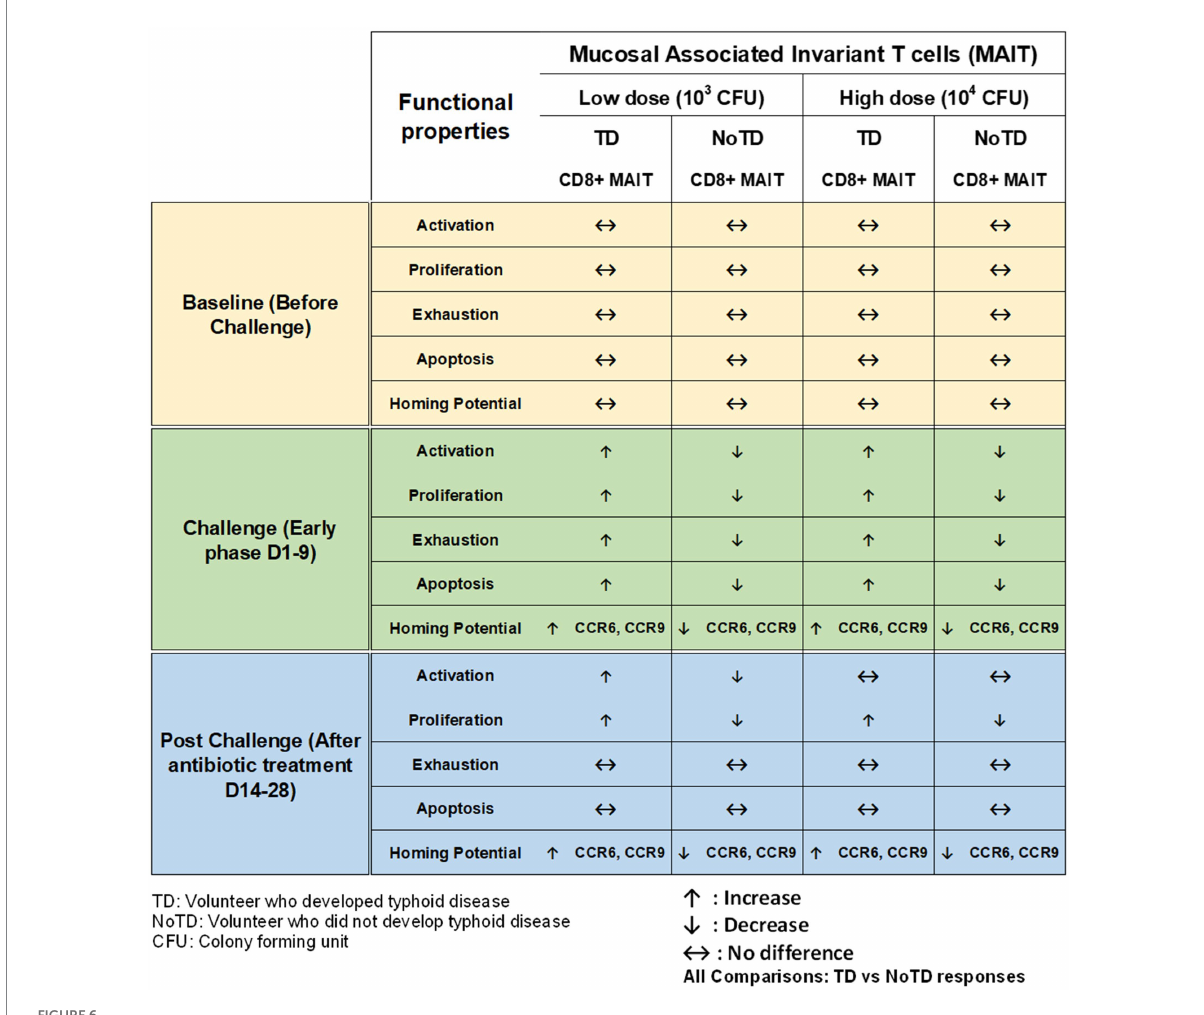
FIGURE 6 Characteristics of MAIT cells in a typhoid CHIM. Summary of MAIT cell responses reported by Salerno-Goncalves et al. (2010, 2017) including comparisons between TD and NoTD at baseline (before challenge), early days after challenge (D1-9) and at later time points after challenge (D14- 28) with either of two doses of wt S . Typhi (Low: 10 3 CFU and high: 10 4 CFU). ↑ : Increase; ↓ : Decrease; ↔ : No